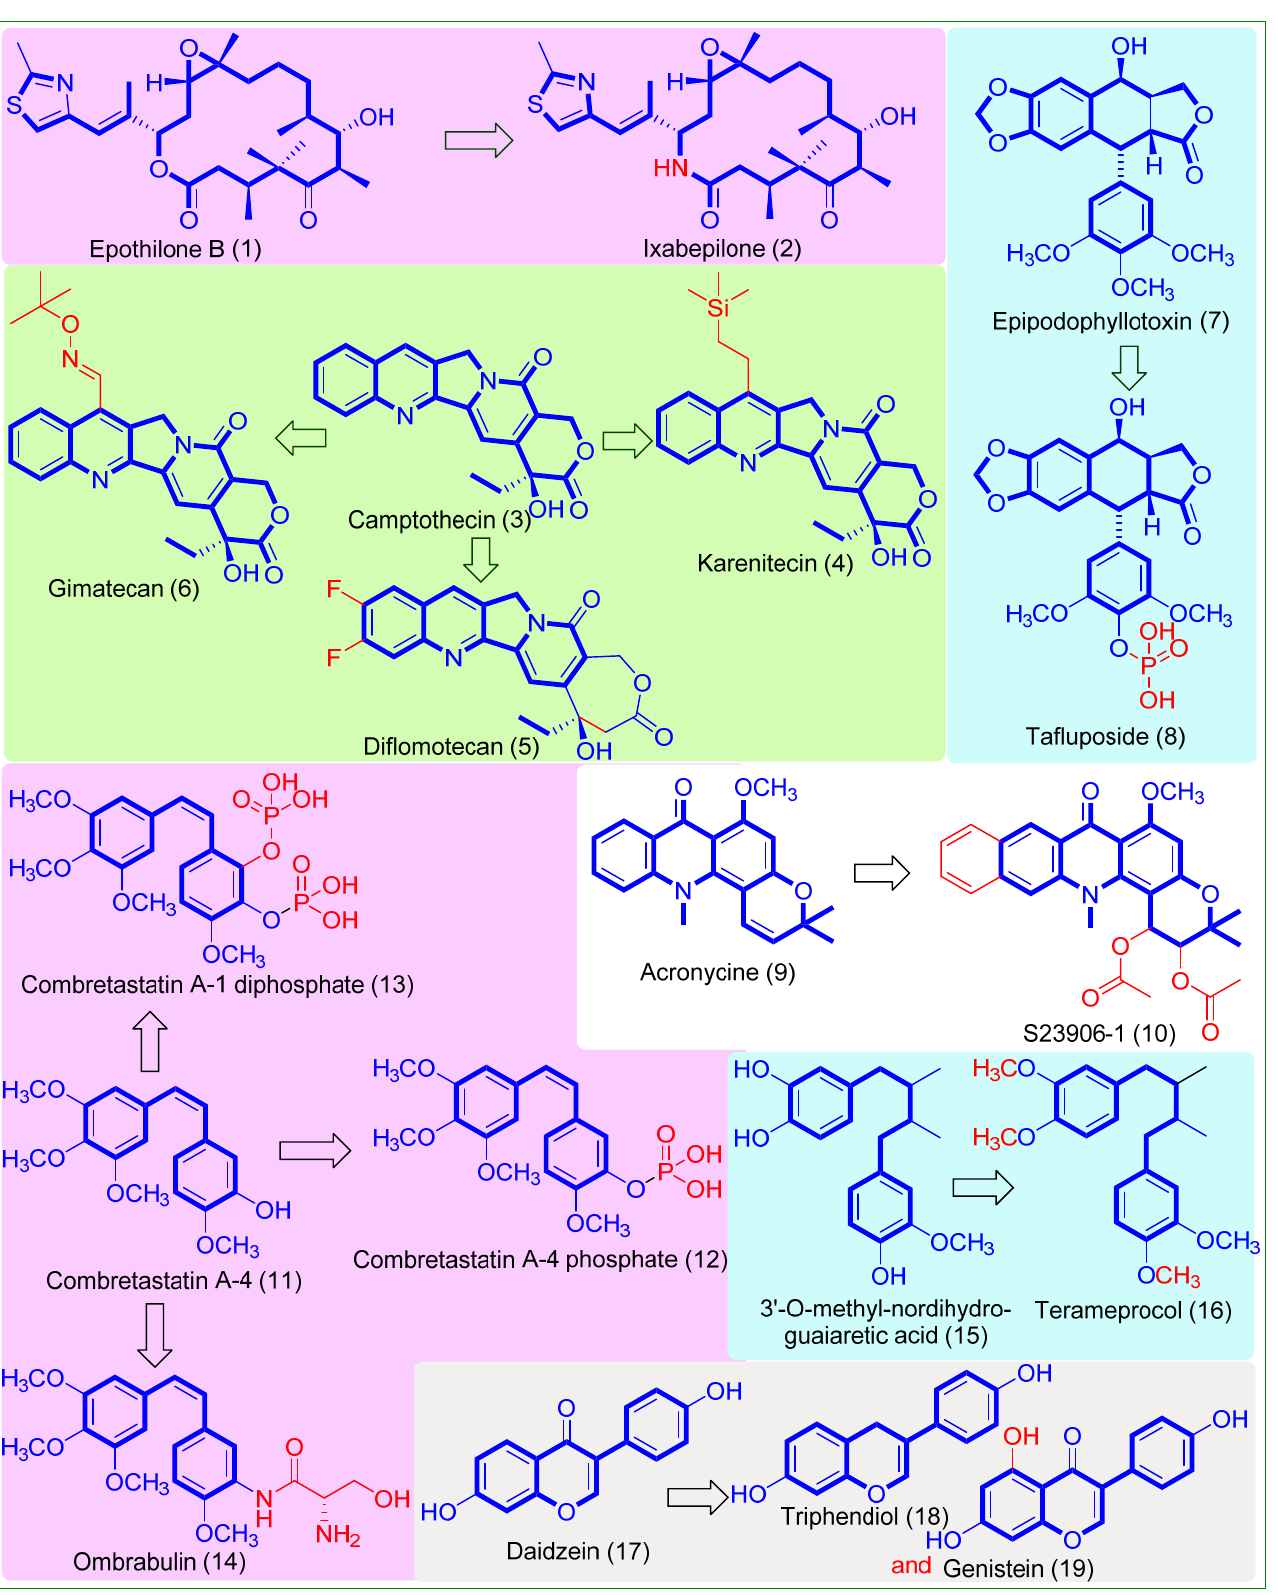
Figure 1. Anticancer drugs derived from natural products [NPs; epothilone B ( 1 ), camptothecin ( 3 ), epipodophyllotoxin ( 7 ), acronycine ( 9 ), combretastatin A-4 ( 11 ), 3’- O -methylnordihydroguaiaretic acid ( 15 ), and daidzein ( 17 )] by chemical modification.